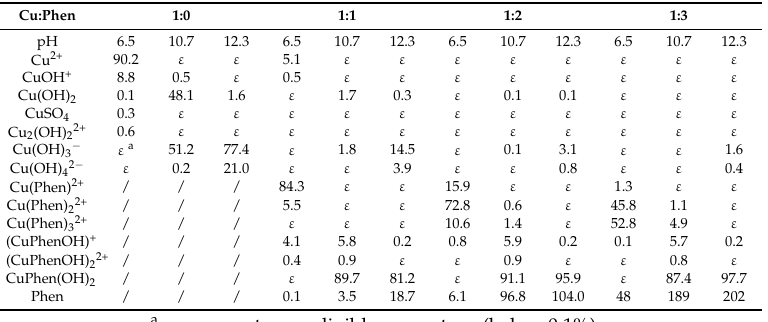
Table 1. Predicted abundances (expressed as percentages of total Cu) of the different species at pH 6.5, 10.7 and 12.3, for Cu:Phen molar ratios = 1:0, 1:1, 1:2 and 1:3, with an initial CuSO 4 concentration of 15 µ M at 25 ◦ C, assuming no precipitation occurrence. The results are given as molar percentages of total